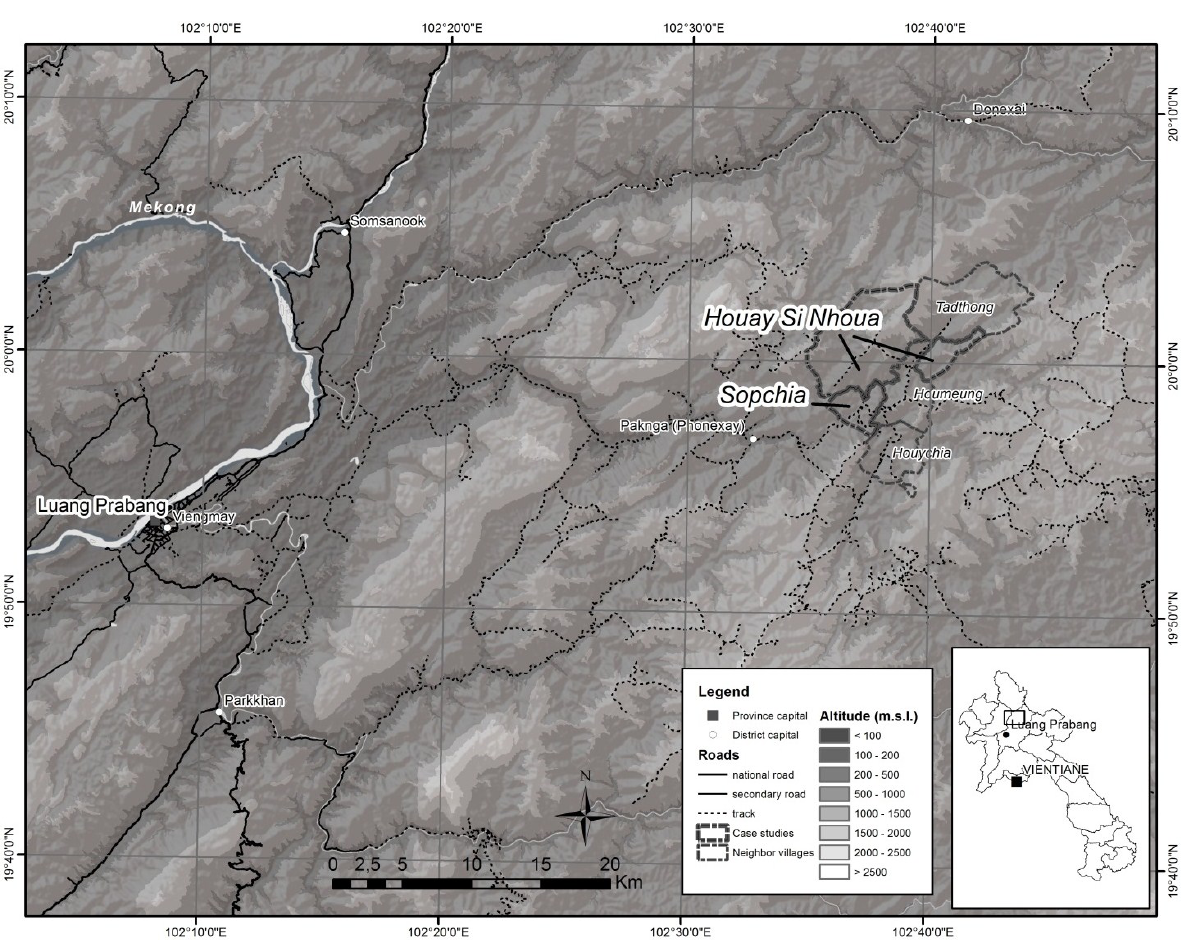
Figure 1. Locations of the case study